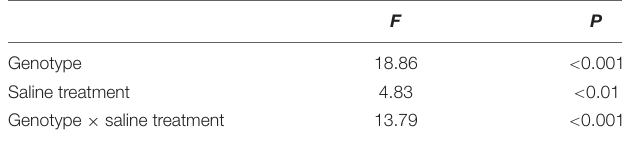
TABLE 4 | Two-way ANOVA examining the effects of genotype, saline treatment and their interaction (genotype × saline treatment) on the V k of leaves from the three P. amurensis sample